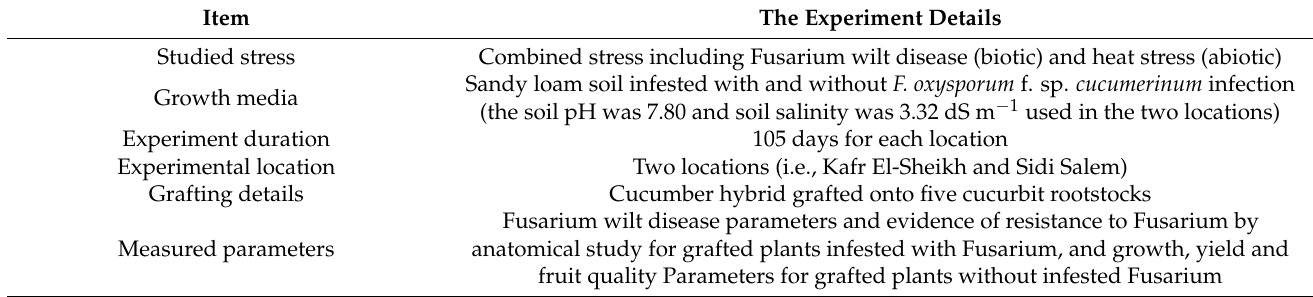
Table 3. Experimentation details for the current